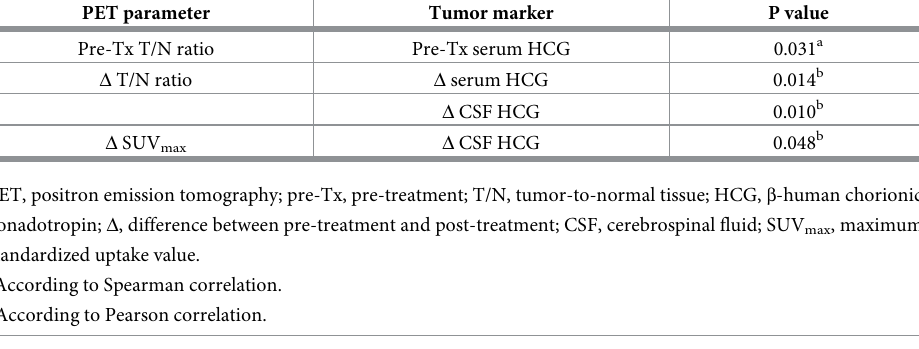
Table 3. Significant correlations between PET parameters and HCG.